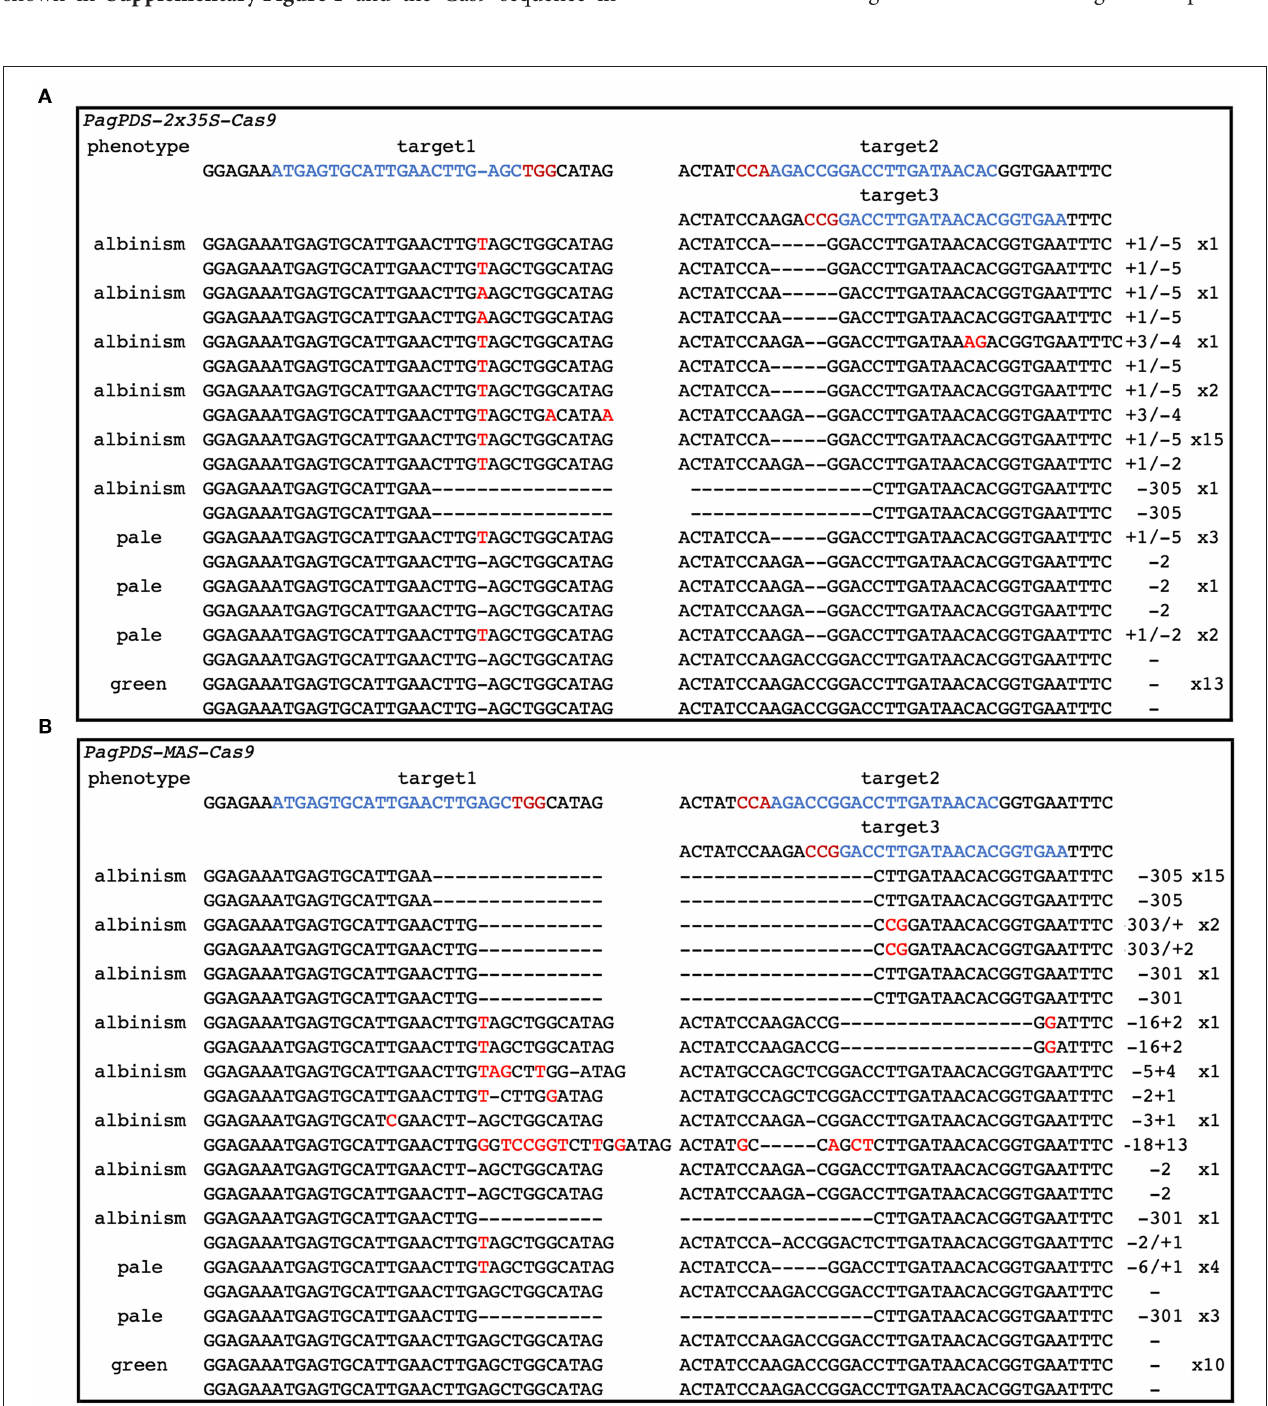
FIGURE 4 | CRISPR/Cas9-mediated gene editing in transgenic poplar plants. (A) Editing situation in PagPDS-2 × 35S-Cas9 plants. (B) Editing situation in PagPDS-MAS-Cas9 plants.